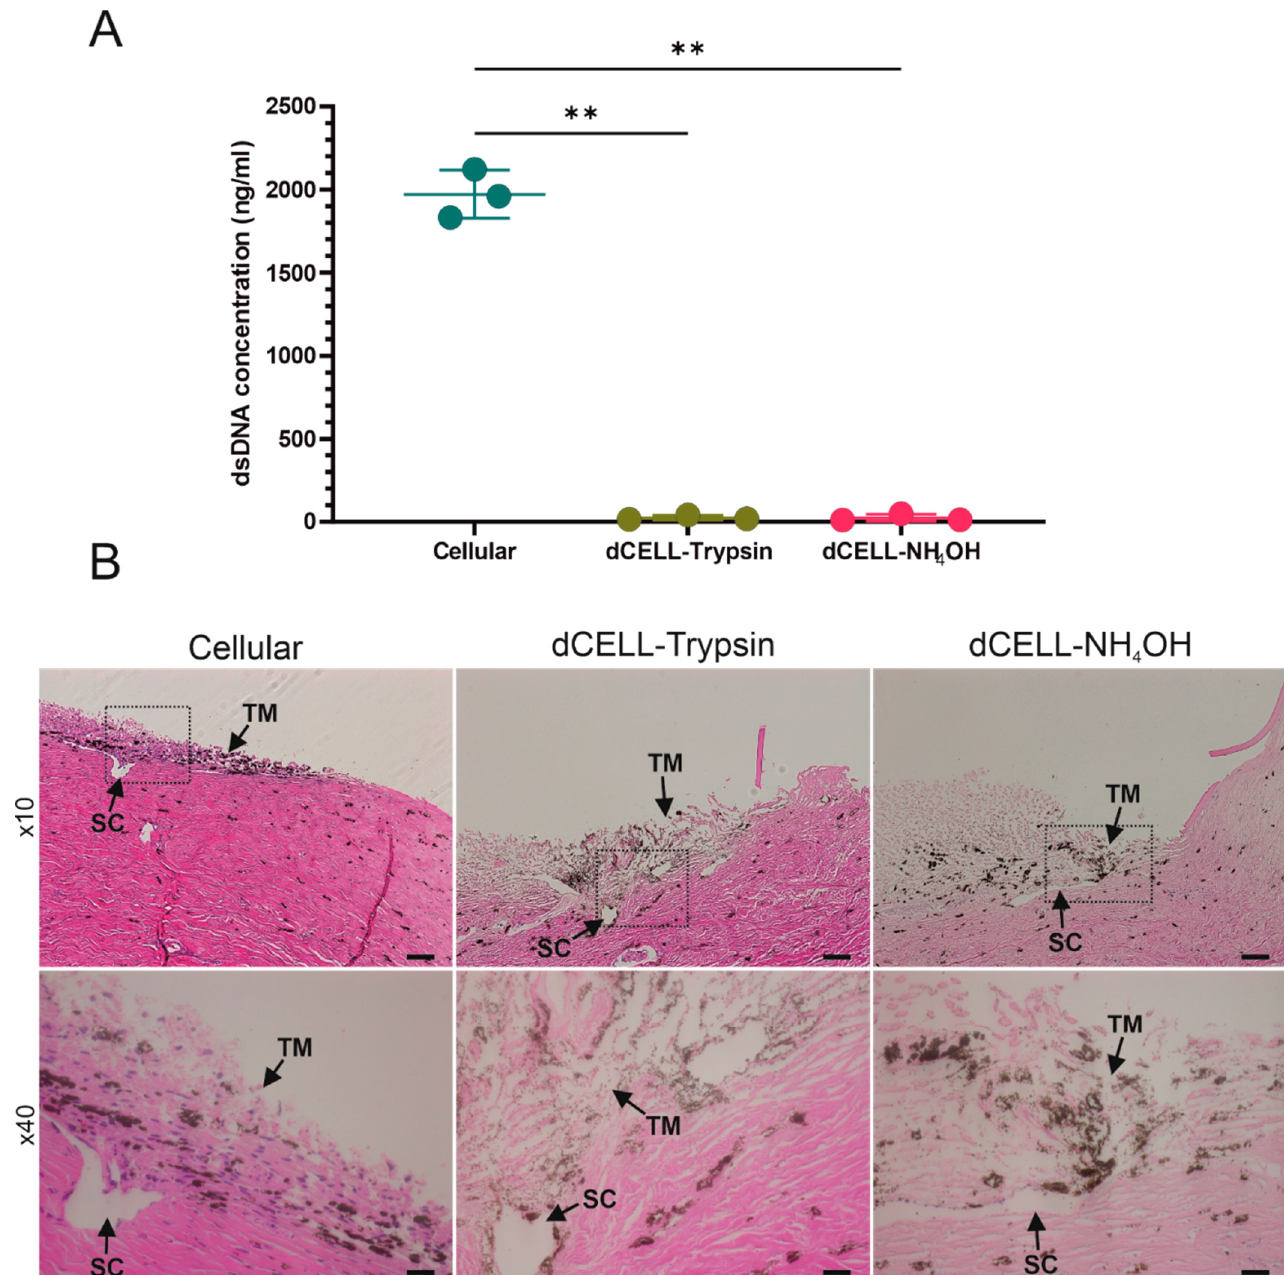
Figure 3. ( A ) Comparison of double-strand DNA concentration in cellular and decellularized (dCELL) bovine trabecular meshwork using either Trypsin (0.05%, 2 h) or Ammonium Hydroxide (NH 4 OH; 2%, 2 h). One-way repeated measures ANOVA with Tukey’s multiple comparisons (n = 3), significance for p < 0.05, ** represents p < 0.01. ( B ) H&E-stained images of cellular and dCELL bovine trabecular meshwork. Trabecular meshwork (TM) and Schlemm’s canal (SC) located by black arrows. Dashed black box in x10 magnification images indicate region of interest for x40 magnification images. BTM structure contains regions of pigmentation. Scale bars = 50 µm (x10) and 20 µm (x40).